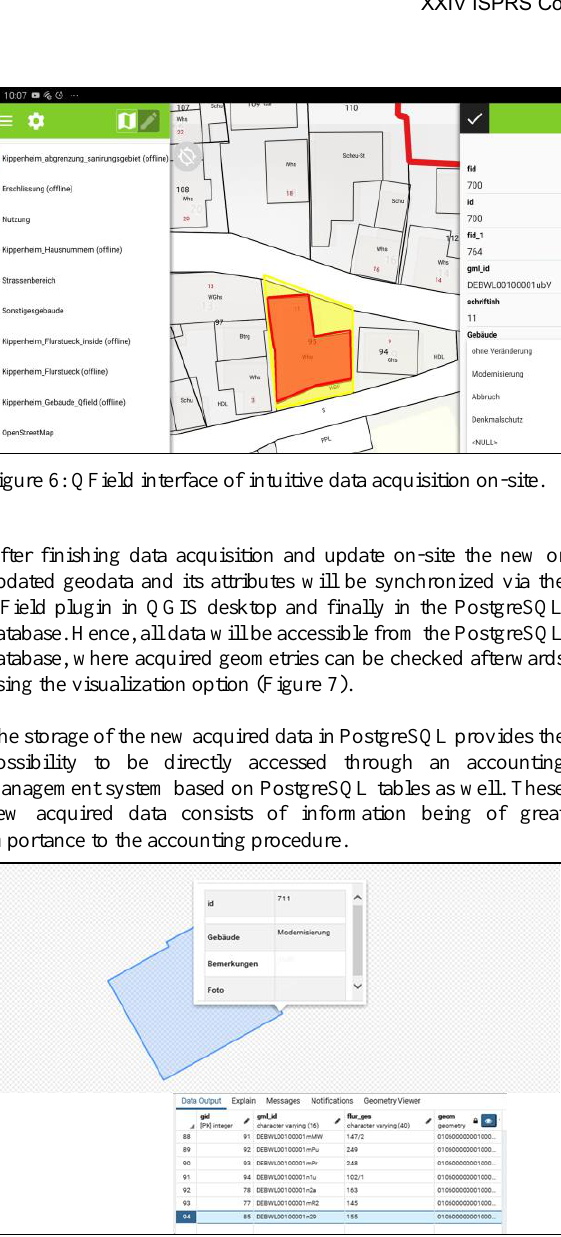
Figure 7: Updating process of the acquired data from QField in PostgreSQL database.